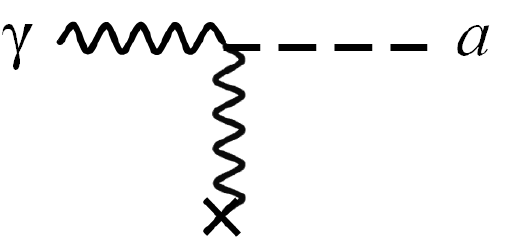
Figure 2. γ → a conversion in the external magnetic field B .